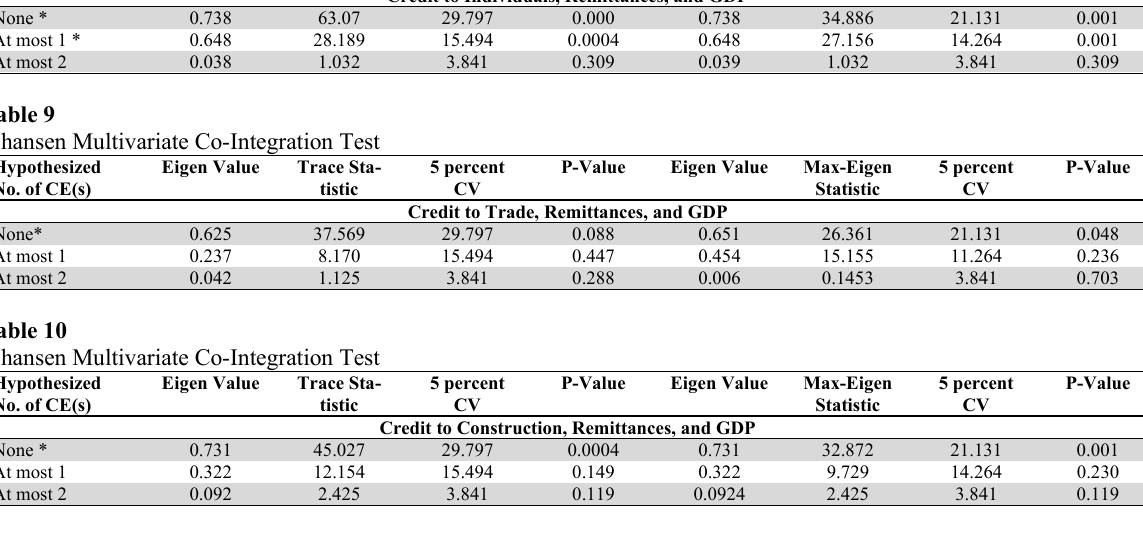
Johansen Multivariate Co-Integration Test Hypothesized No. of CE(s)